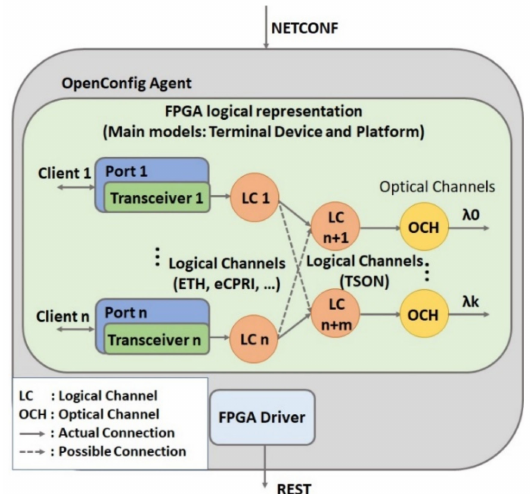
Figure 18. Logical representation of the TSON node based on OpenConfig. OCH: optical channel, LC: logical